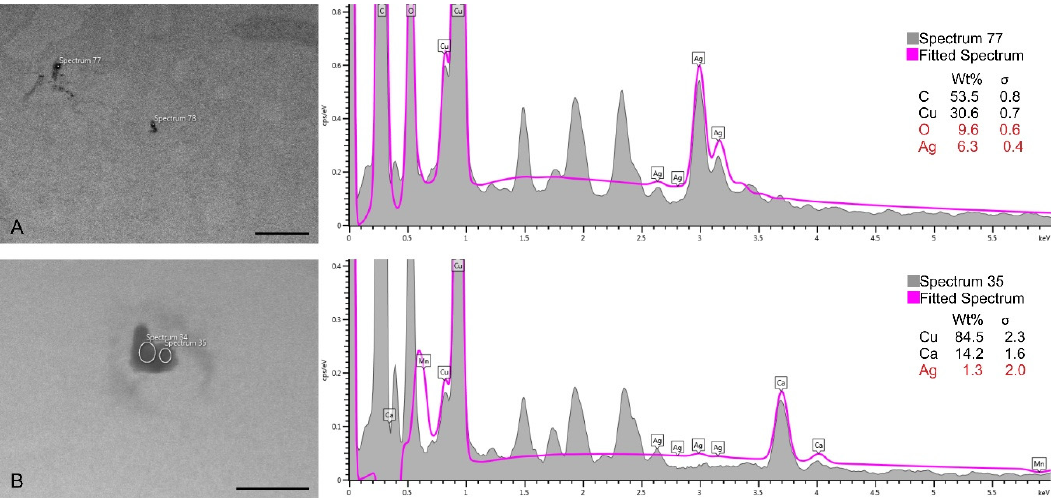
Figure 11. TEM micrographs of the tested cells and EDX spectra confirming the presence of silver in the electron-dense accumulations observed inside A375 cells ( A , bar at 1 µm) and HaCaT cells ( B , bar at 250